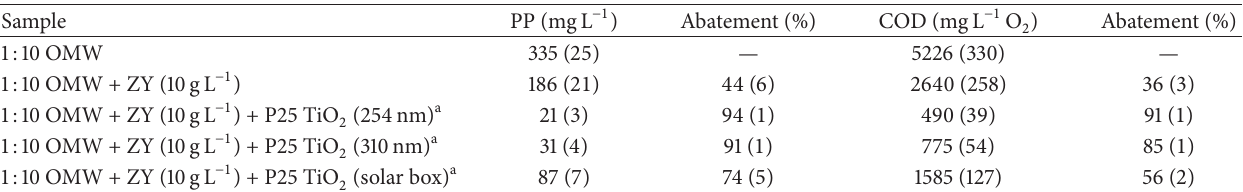
a 1gL −1 photocatalyst, 8h